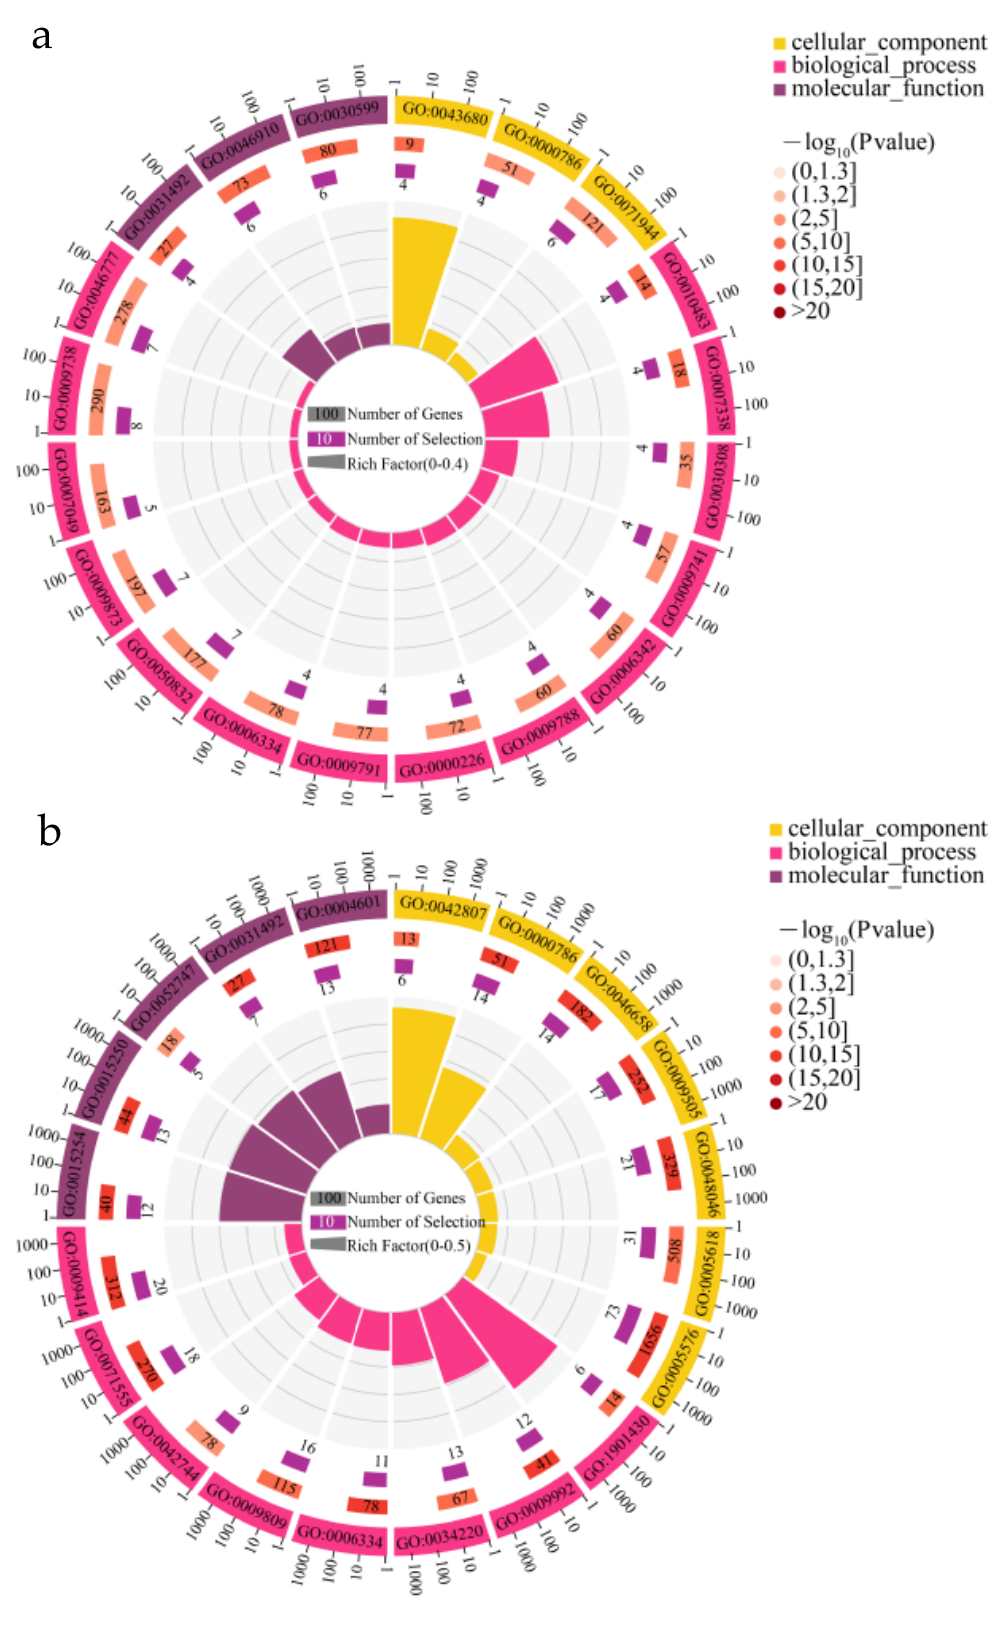
Figure 6. GO analysis of differential gene: 13 d vs. 1 d ( a ) and 27 d vs. 1 d ( b